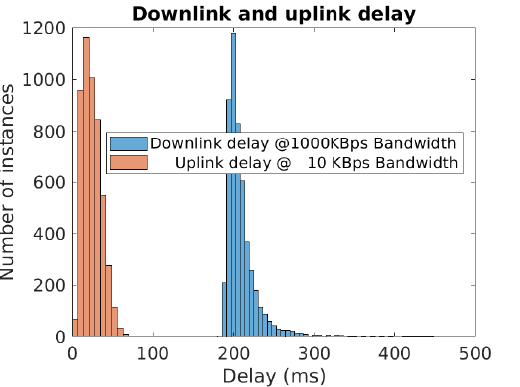
Figure 2. Delays observed in data transmission over 4G. Reprinted with permission from Ref.